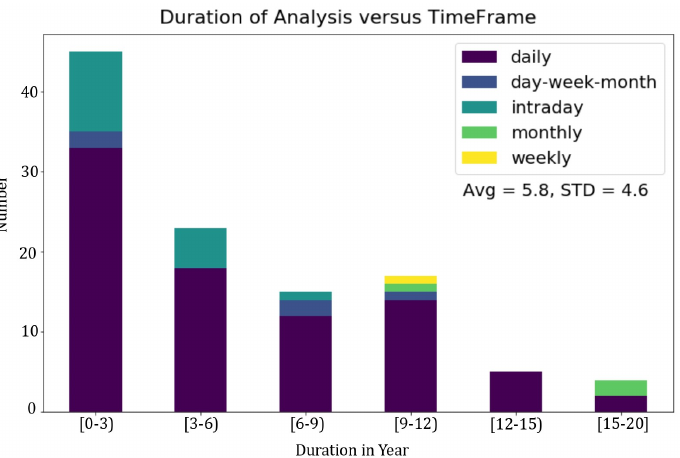
Figure 5. Histogram plot of duration of analysis in the surveyed papers versus time frames.